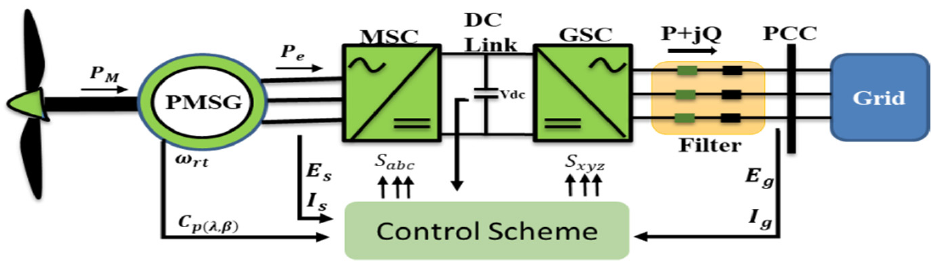
Figure 1. PMSG based GCWT System.